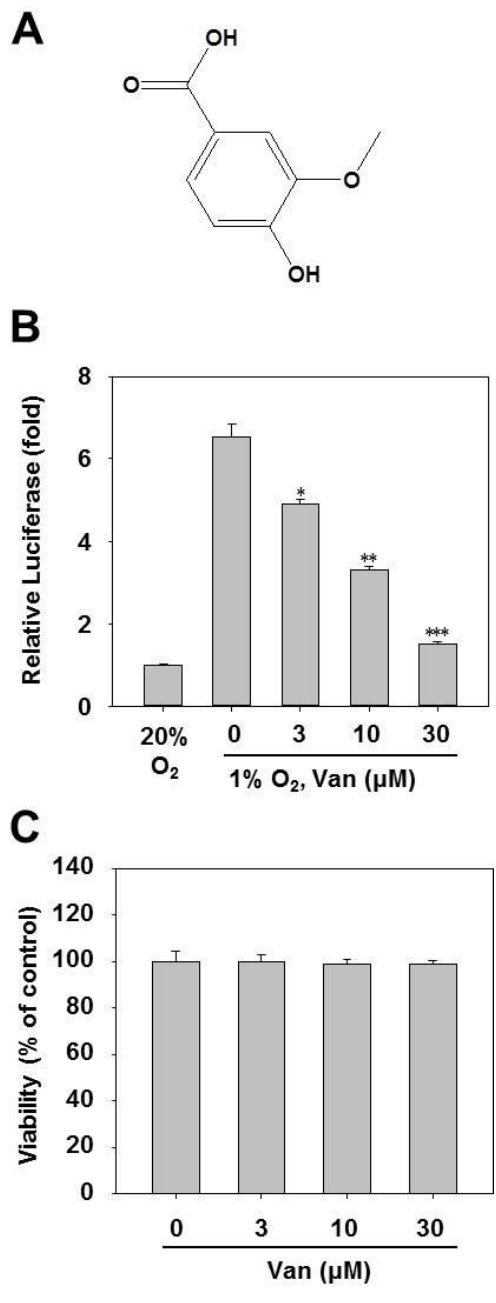
Figure 1. Identification of vanillic acid (Van) as a HIF-1 pathway inhibitor from a cell-based screening assay. ( A ) Chemical structure of vanillic acid (Van). ( B ) HCT116 cells were transiently co-transfected with a pGL3-HRE-Luciferase and pRL-CMV vectors. Following 24 h incubation, cells were treated with various concentrations of vanillic acid (Van) and then subjected to hypoxia, or remained in normoxia for 12 h. Data were shown as mean ± SD ( n = 3). * p < 0.05, ** p < 0.01, *** p < 0.001, compared with hypoxia control. ( C ) Cells were incubated with different concentrations of vanillic acid (Van). After 24 h incubation, cell viability was determined by MTT